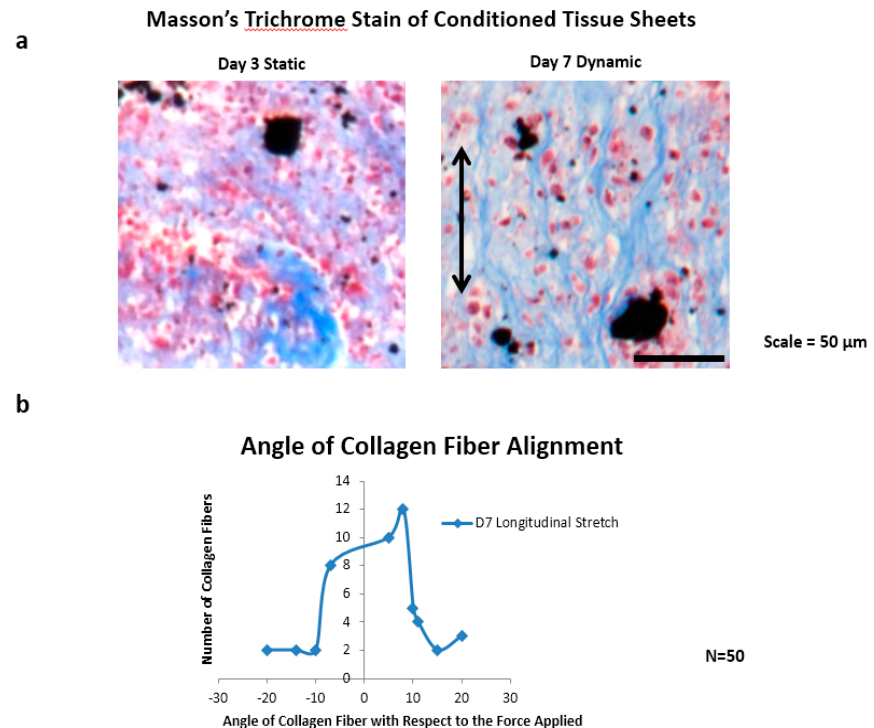
Figure 5. Collagen fiber alignment. ( a ) The presence of collagen fibers after seven days of cyclic longitudinal stretching via magnetic forces as compared to three days of static conditioning; and ( b ) the results of the measurement of the angle of 50 collagen fibers with respect to the applied magnetic forces: of the 50 fibers measured, 37 were within 10 degrees of the axis of the applied forces.